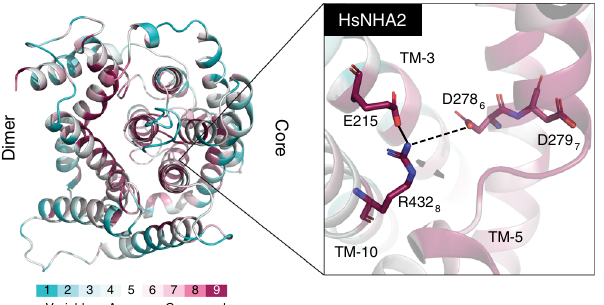
Fig. 4 Model structure of HsNHA2. Left: periplasmic view, colored by the ConSurf evolutionary conservation bar at the bottom. The dimerization domain is on the left and core domain on the right. Right: close-up view of the unique polar interaction between TM-3, TM-5, and TM-10 characteristic of HsNHA2-like PCAs. The three residues involved are highly conserved. E215 could potentially salt bridge with R432 8 on TM-10. In one plausible scenario D278 6 would be protonated and hydrogen bonded to R432 8 , leaving only D279 7 to alternate its protonation state upon transport, resulting in electroneutral transport. Modeling is based on the structure of TtNapA (PDB id 5BZ2) as